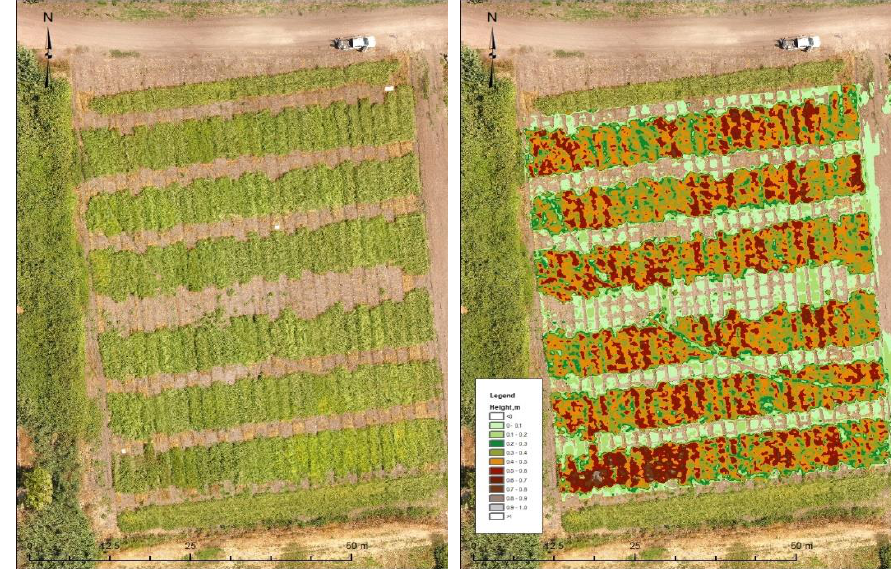
Figure 4 . Aerial RGB photograph (left) and 3D canopy height modeling (right) of the 2019 experiment in week 7 after emergence. The arc-like line is the track mark made by the linear move irrigation system when shifting to the adjacent experimental plot.